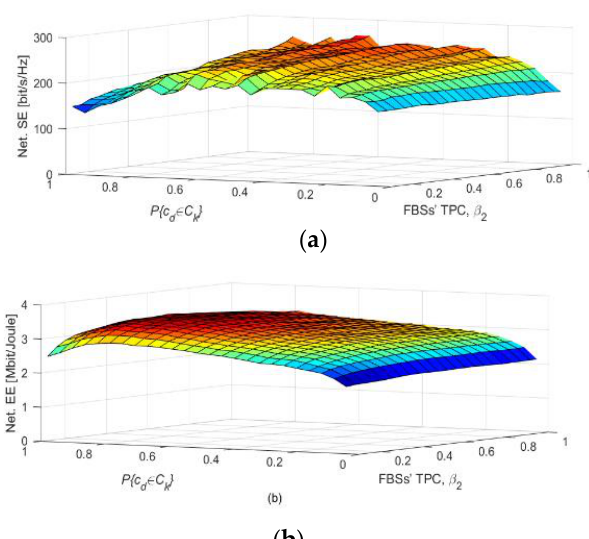
Figure 22. The relationship between the network SE ( a )/EE ( b ), the FBSs’ TPC (i.e., 𝛽 2 ), and ℙ{𝑐 𝑑 ∈ Ϲ 𝑘 } = | C k | (in this figure, k is set to 2, i.e., the femto tier). Note that P { c d ∈ C k } is the probability that the D2D channel c d belongs to the channels allocated to the k -th tier.